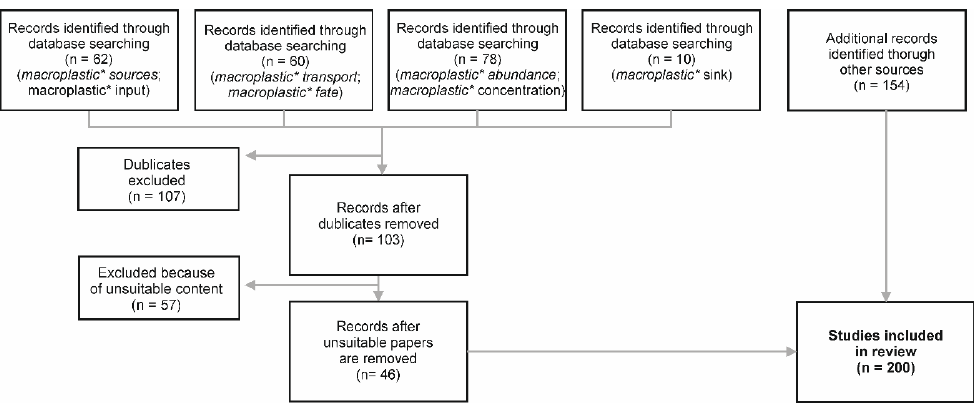
Figure 1. Overview of the literature collection used as a basis for this review.